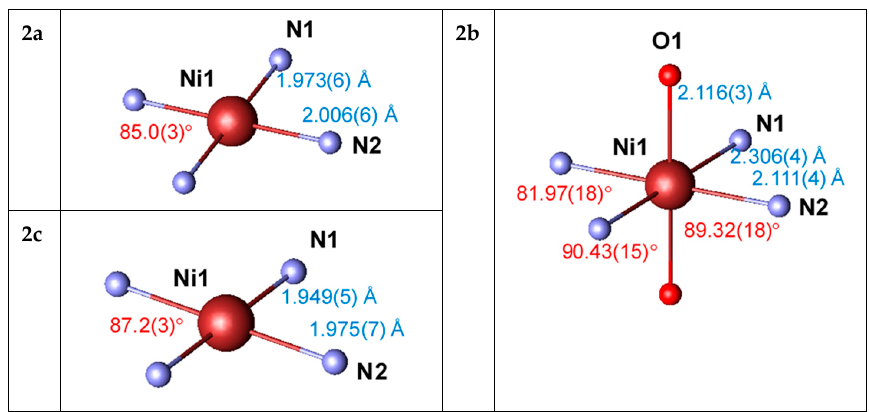
Figure 9. Distances and angles of bonds around Ni(ii) ion of 2a , 2b , and 2c . Figure 8. Crystal structure of 2a , 2b , and 2c .